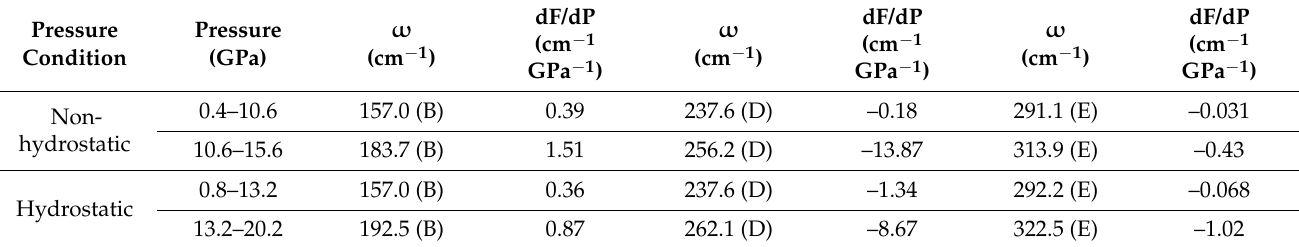
Table 2. Pressure dependence of Raman FWHM (dF/dP; cm − 1 GPa − 1 ) for Ga 2 Se 3 under non-hydrostatic and hydrostatic environments. Here, ω , F, and P are the Raman frequency, Raman FWHM, and pressure, respectively. The listed ω values are obtained at 0.4 GPa within the pressure range of 0.4–10.6 GPa and at 10.6 GPa within the pressure range of 10.6–15.6 GPa under non-hydrostatic conditions, respectively. The listed ω values are acquired at 0.8 GPa within the pressure range of 0.8–13.2 GPa and at 13.2 GPa within the pressure range of 13.2–20.2 GPa under hydrostatic conditions,